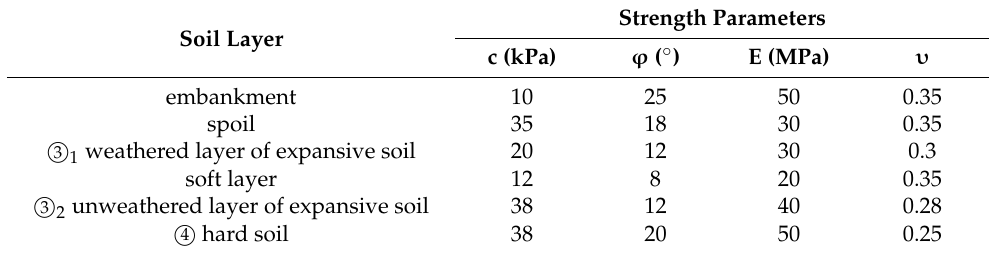
Table 2. Calculation parameters of